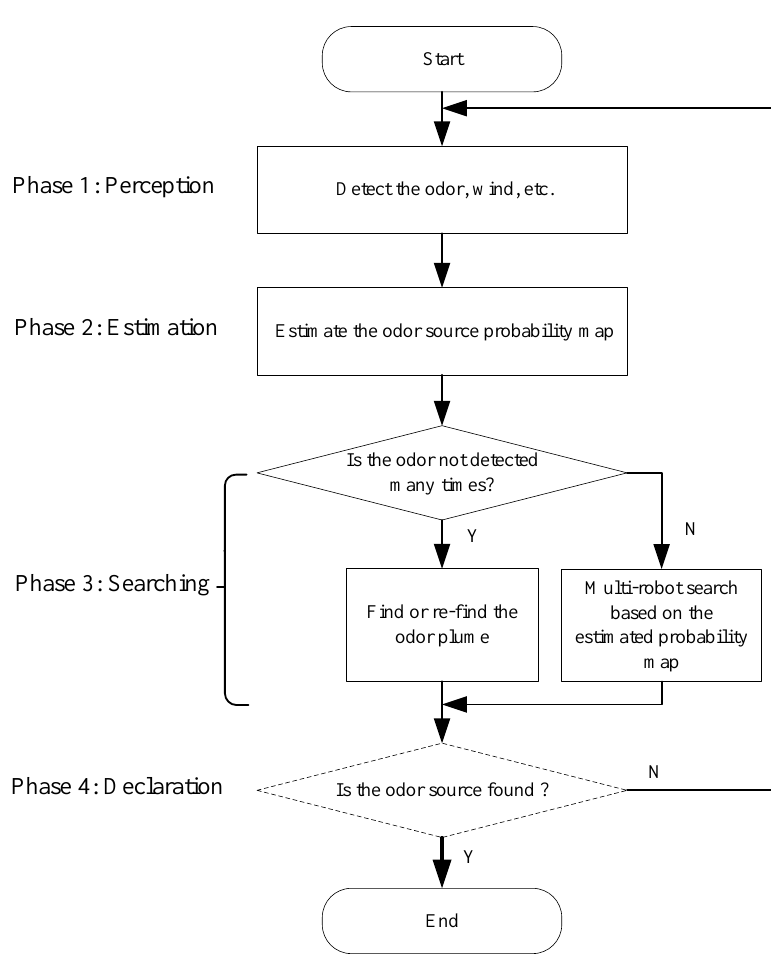
Figure 2. The flowchart of the proposed gas source localization strategy.